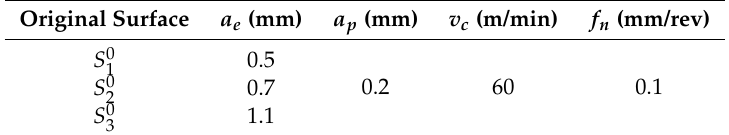
Table 3. Milling parameters for the machining preparation of the three original surfaces.